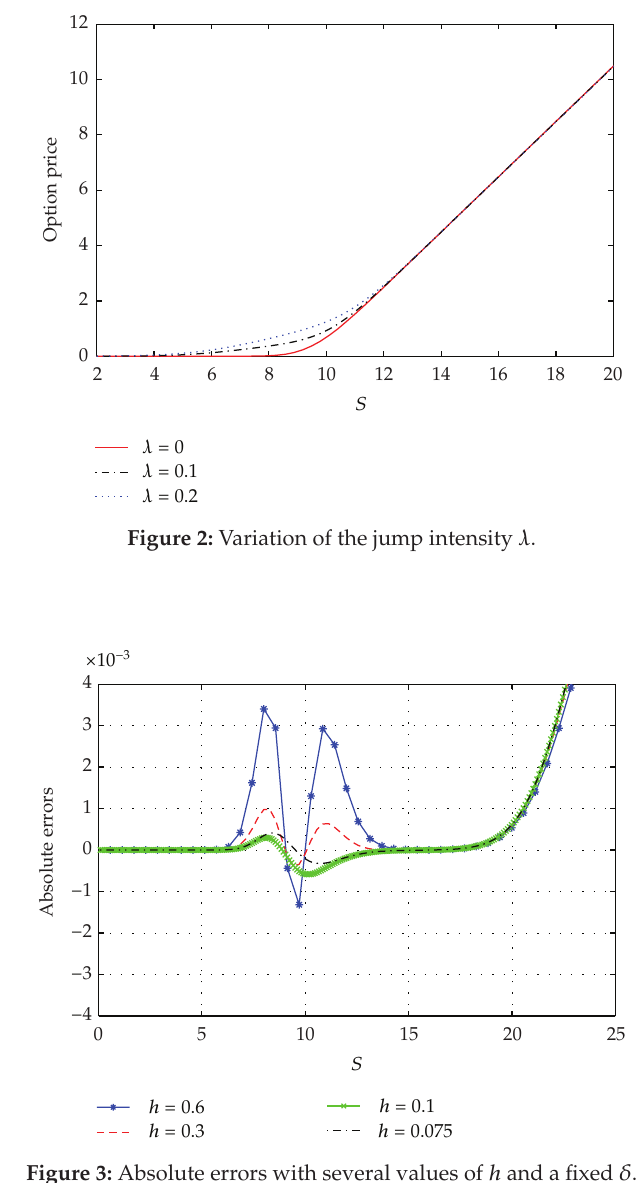
Figure 3: Absolute errors with several values of h and a fixed δ